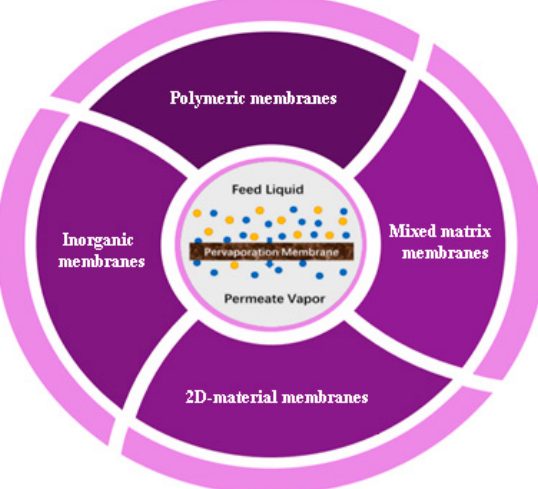
Figure 4. Classification of membranes.